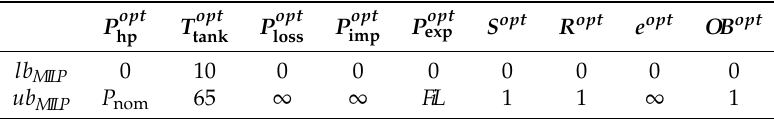
Table 1. Lower ( lb MILP ) and upper ( ub MILP ) system boundaries at each time step for the MILP optimisation